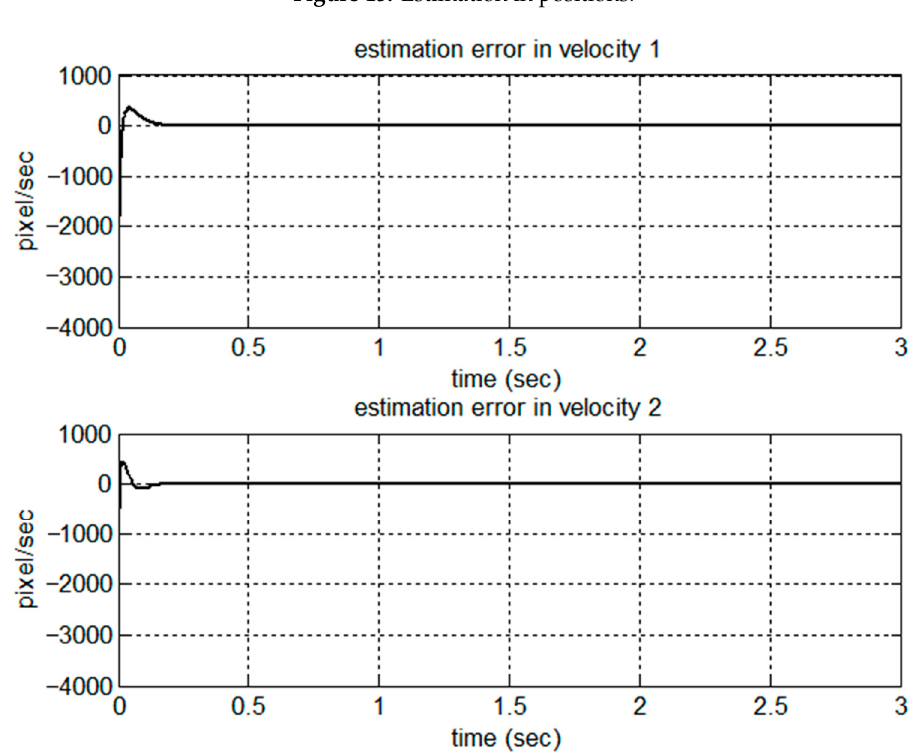
Figure 15. Estimation in positions.